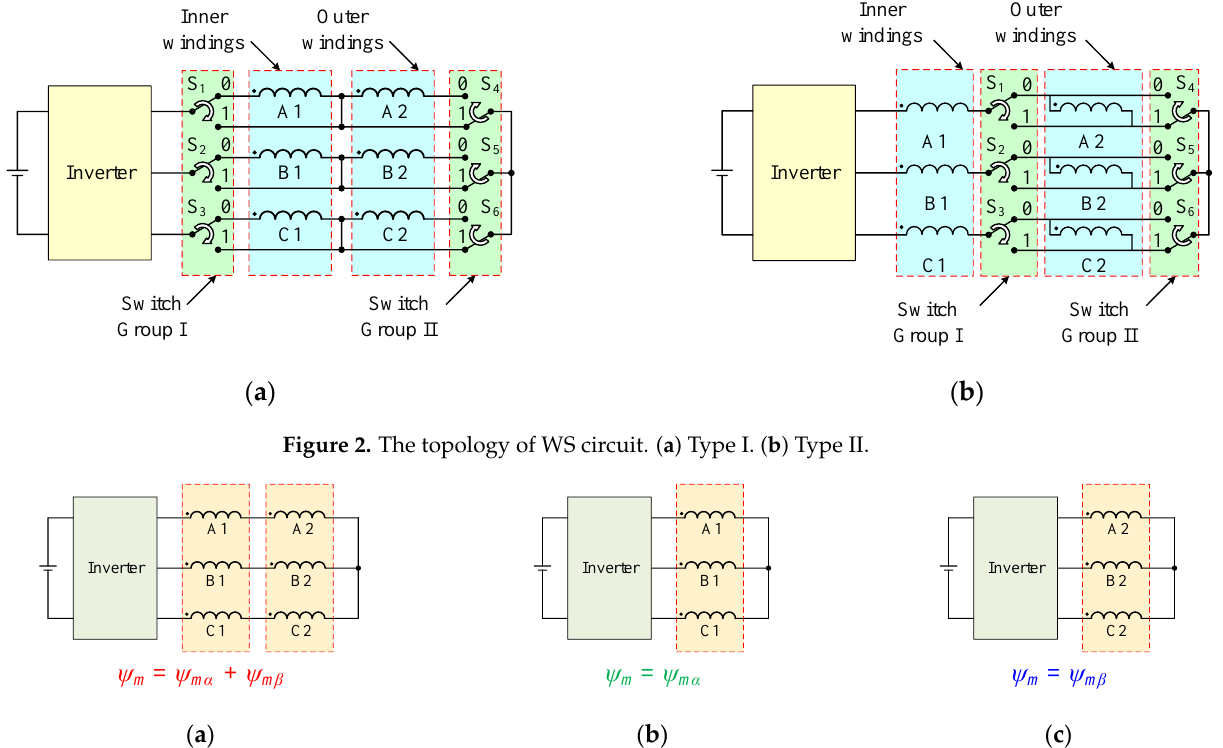
Figure 2. The topology of WS circuit. ( a ) Type I. ( b ) Type II.